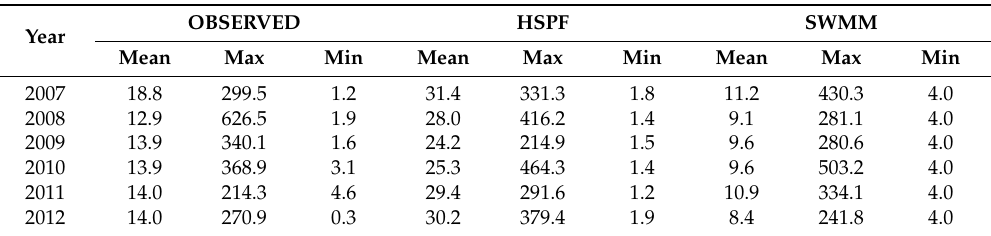
Table 8. Comparison between daily flows simulated by the HSPF model and SWMM and observed data (m 3